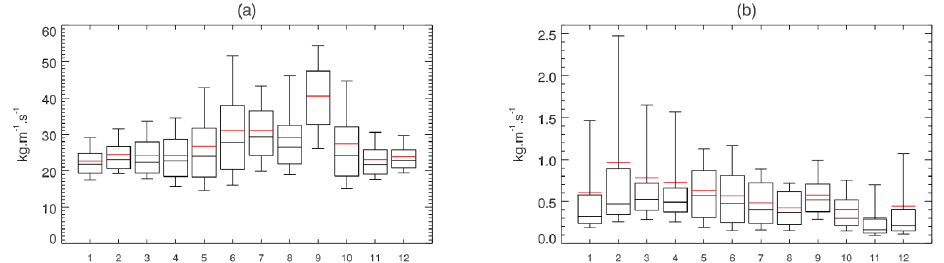
Figure 5. Box plots of the decadal average of the vertically integrated water vapour flux (a) and cloud particle flux (b) on the inner TP for HAR10 (kgm − 1 s − 1 ) . The boxes represent the range from the 25th to the 75th percentile. The boxes are divided by the median value (black) and the mean value (red). The whiskers represent the 10th and the 90th percentile, respectively. Note the different scales of the y